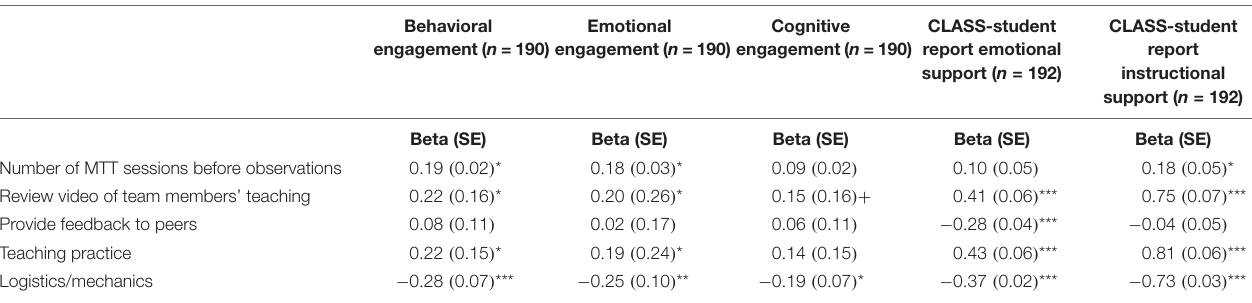
TABLE 7 | Predicting student reported classroom experiences with number of MTT sessions and topics discussed in sessions a